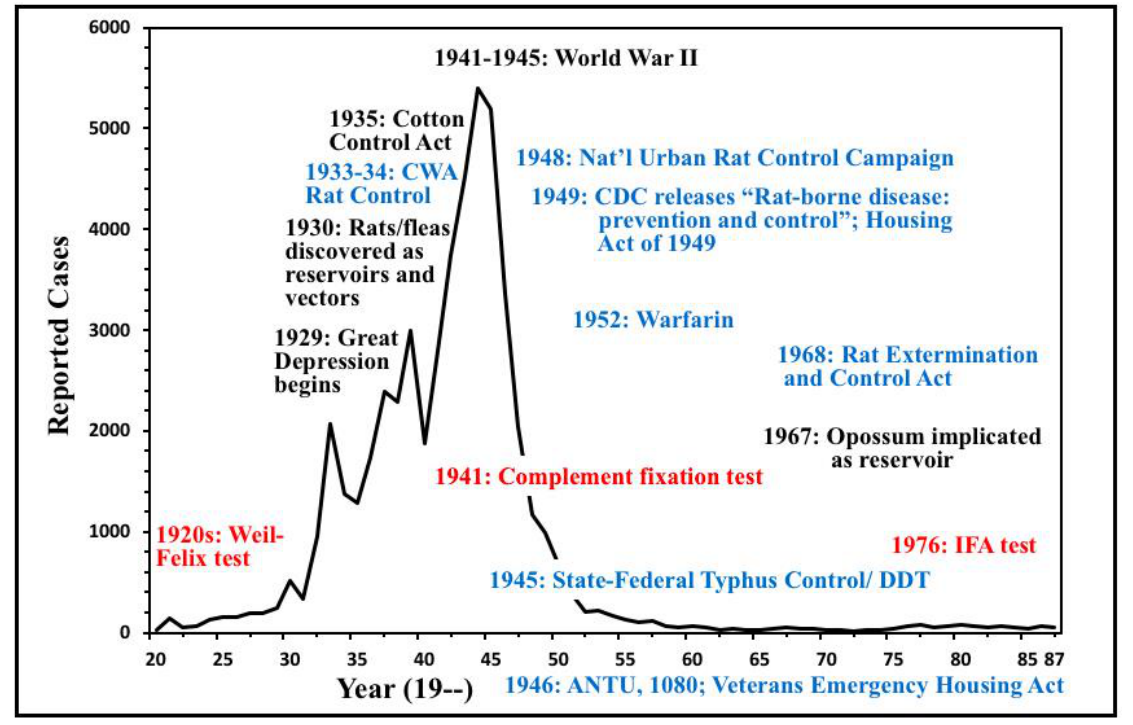
Figure 14. Epidemiologic curve of flea-borne typhus in the United States, 1920–1987 [2]. There are superimposed time points for: major developments in diagnostic testing (red); historical events that affected the epidemiology [4] (black); and the introduction of technologies and programs for typhus control (blue). (CWA is the Civil Works Administration).